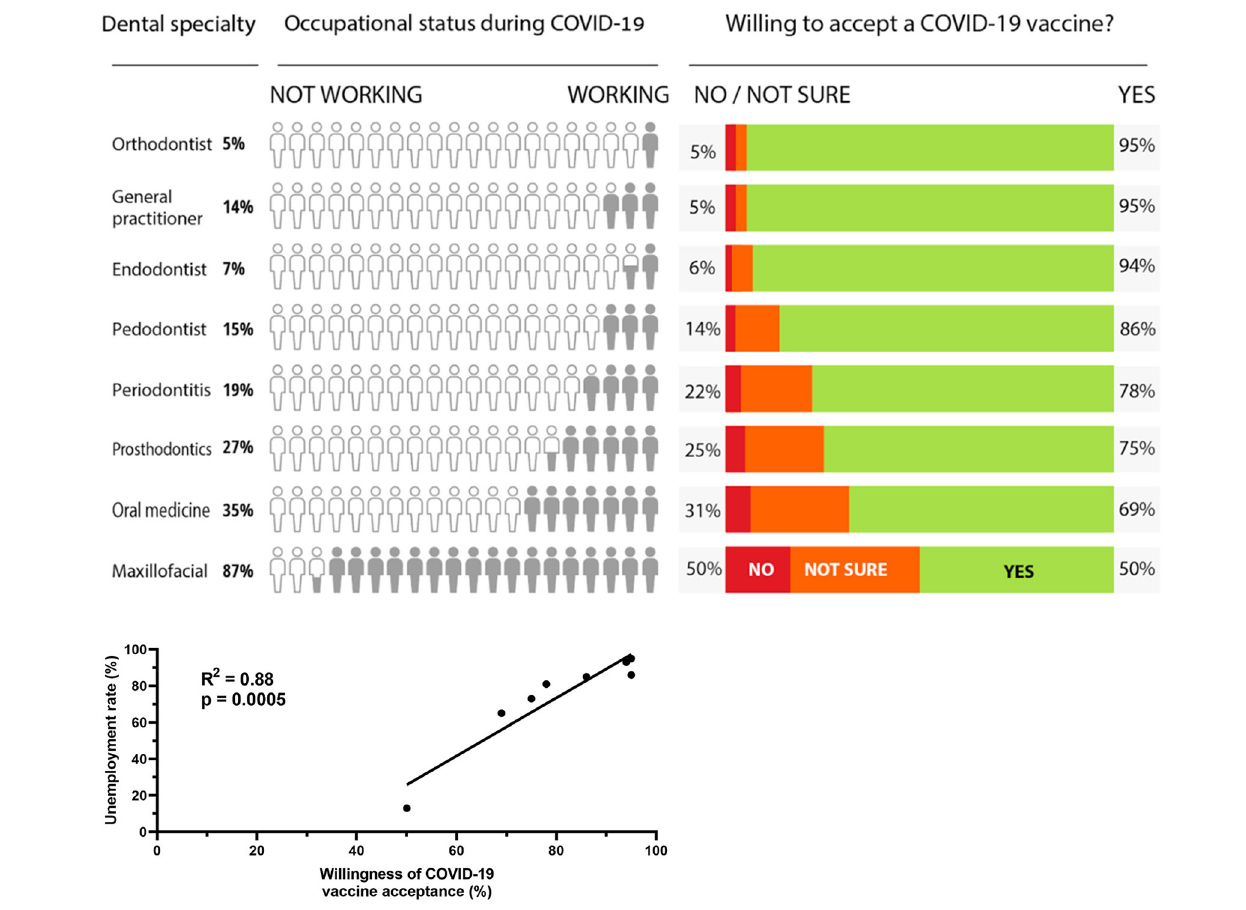
OMFS surgeons (residents and specialists) is the lowest (50%, r =